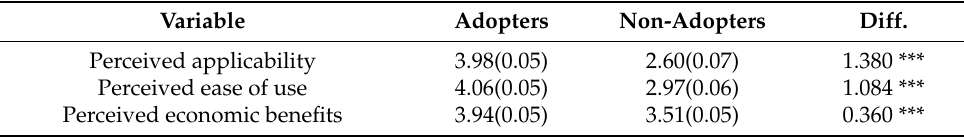
Table 3. Mean difference of farmers’ absorptive capacity between adopters and non-adopters.